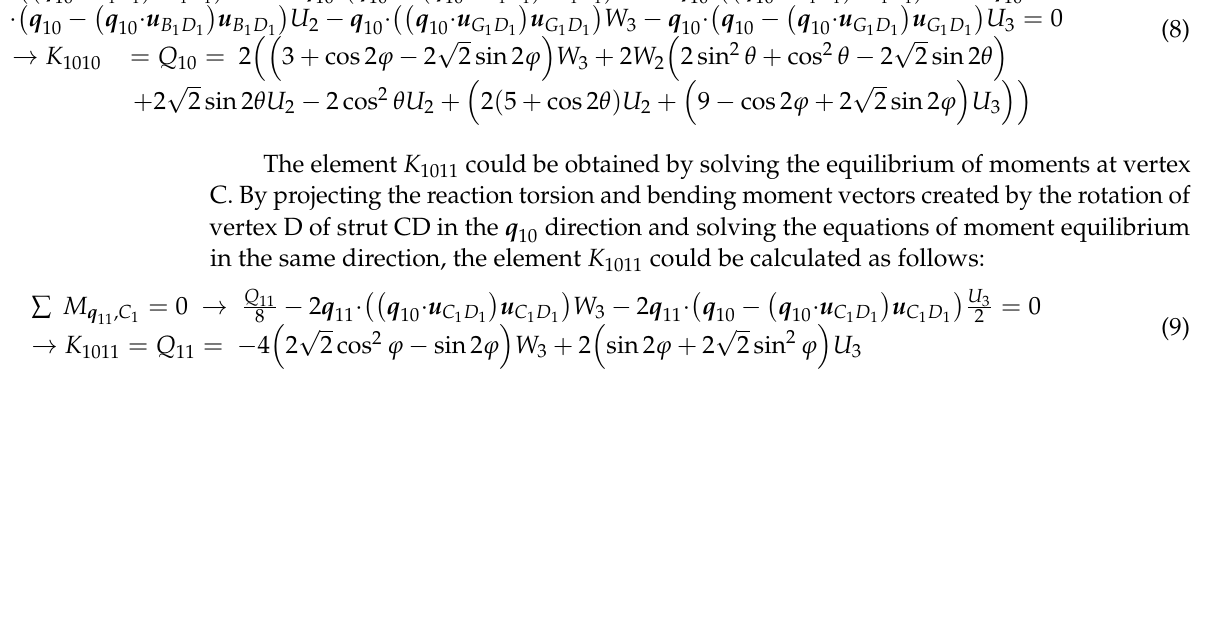
The 10th DOF: q 10 = 1 This DOF is a complex deformation in the structure because it applies rotation at vertex D, which is connected to six struts (2 × DC, 2 × DE, DG, and DB). By pro- jecting vector q on the noted struts, the torsion applied to each of the struts can be 10 sional parameter of each strut ( W 2 and W 3 ) by the projected twist, the torque vectors (cid:1) (cid:1) (cid:1) (cid:1) (cid:0)(cid:0) (cid:1) (cid:1) (cid:0)(cid:0) (cid:0)(cid:0) · u · u · u u E u B q u C q q W 2 , W 2 , W 3 , could be obtained as E 1 D 1 B 1 D 1 C 1 D 1 10 10 10 1 D 1 1 D 1 1 D 1 (cid:0)(cid:0) (cid:1) (cid:1) · u q u G W 3 . The extent of flexural rotation of struts DC, DE, DG, and and G 1 D 1 10 1 D 1 DB can be obtained by subtracting the projected twist vector from vector q , which 10 (cid:1) (cid:1) (cid:1) − (cid:0) q · u − (cid:0) q · u − (cid:0) q · u − u C u E u B yields q , q , q , and q E 1 D 1 B 1 D 1 C 1 D 1 10 10 10 10 10 10 10 1 D 1 1 D 1 1 D 1 (cid:0) of each strut (i.e., U 2 and U 3 ) to the noted terms, the lateral force vectors could be calcu- lated. It is worth noting that the terms related to struts CD and ED must be